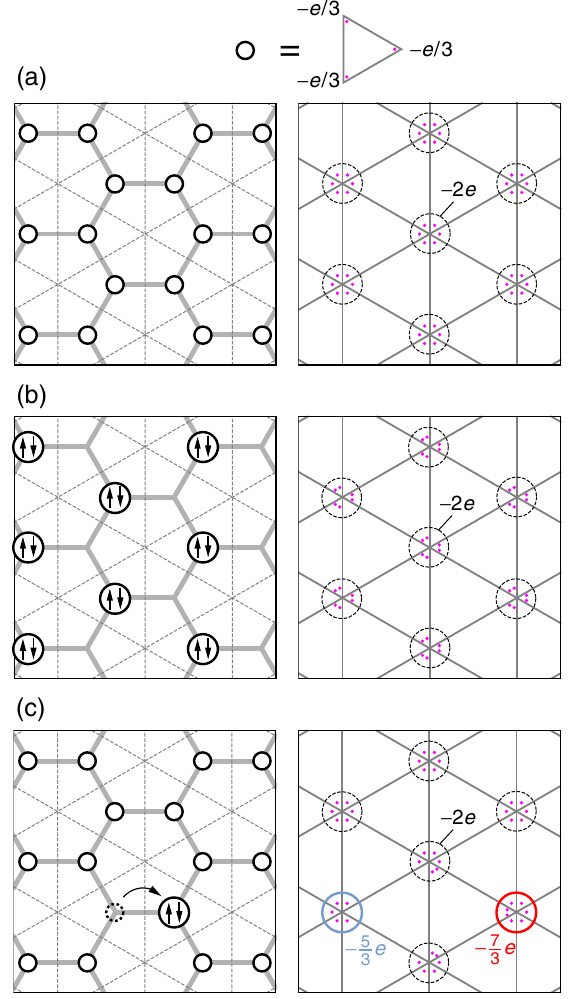
FIG. 7. Several conceivable many-body states illustrated in the honeycomb lattice picture (left panels) and the fractional charge picture (right panels). (a) The homogeneous state where an electron resides at every sublattice. (b) The charge-ordered state where two electrons enter every two sublattices. Opposite arrows in a single site represent two electrons with different spins or valley pseudospins. (c) An excited state from state (a), where an electron is transferred from a single site to